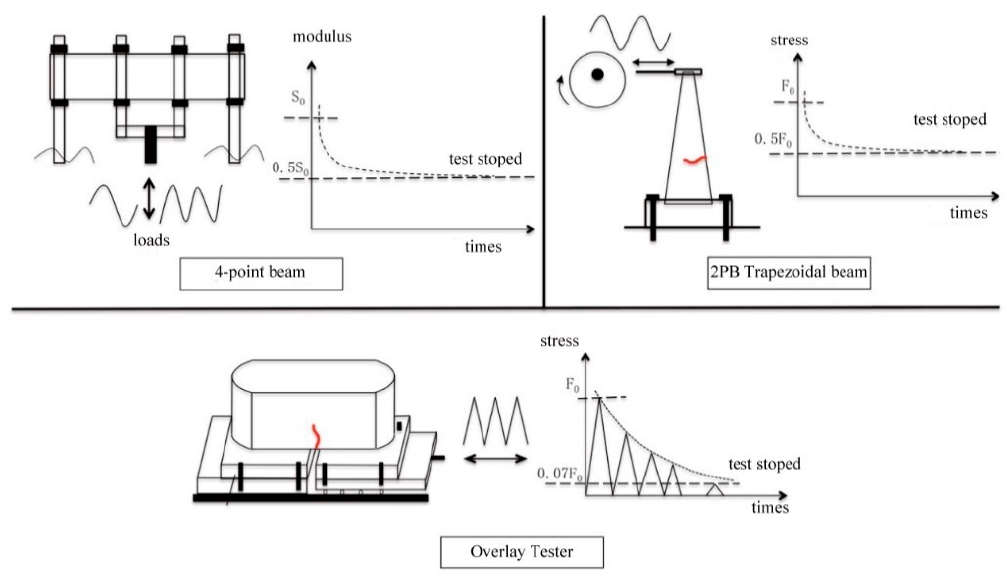
Figure 2. The loading mode and model diagram of three loading modes of the fatigue test.